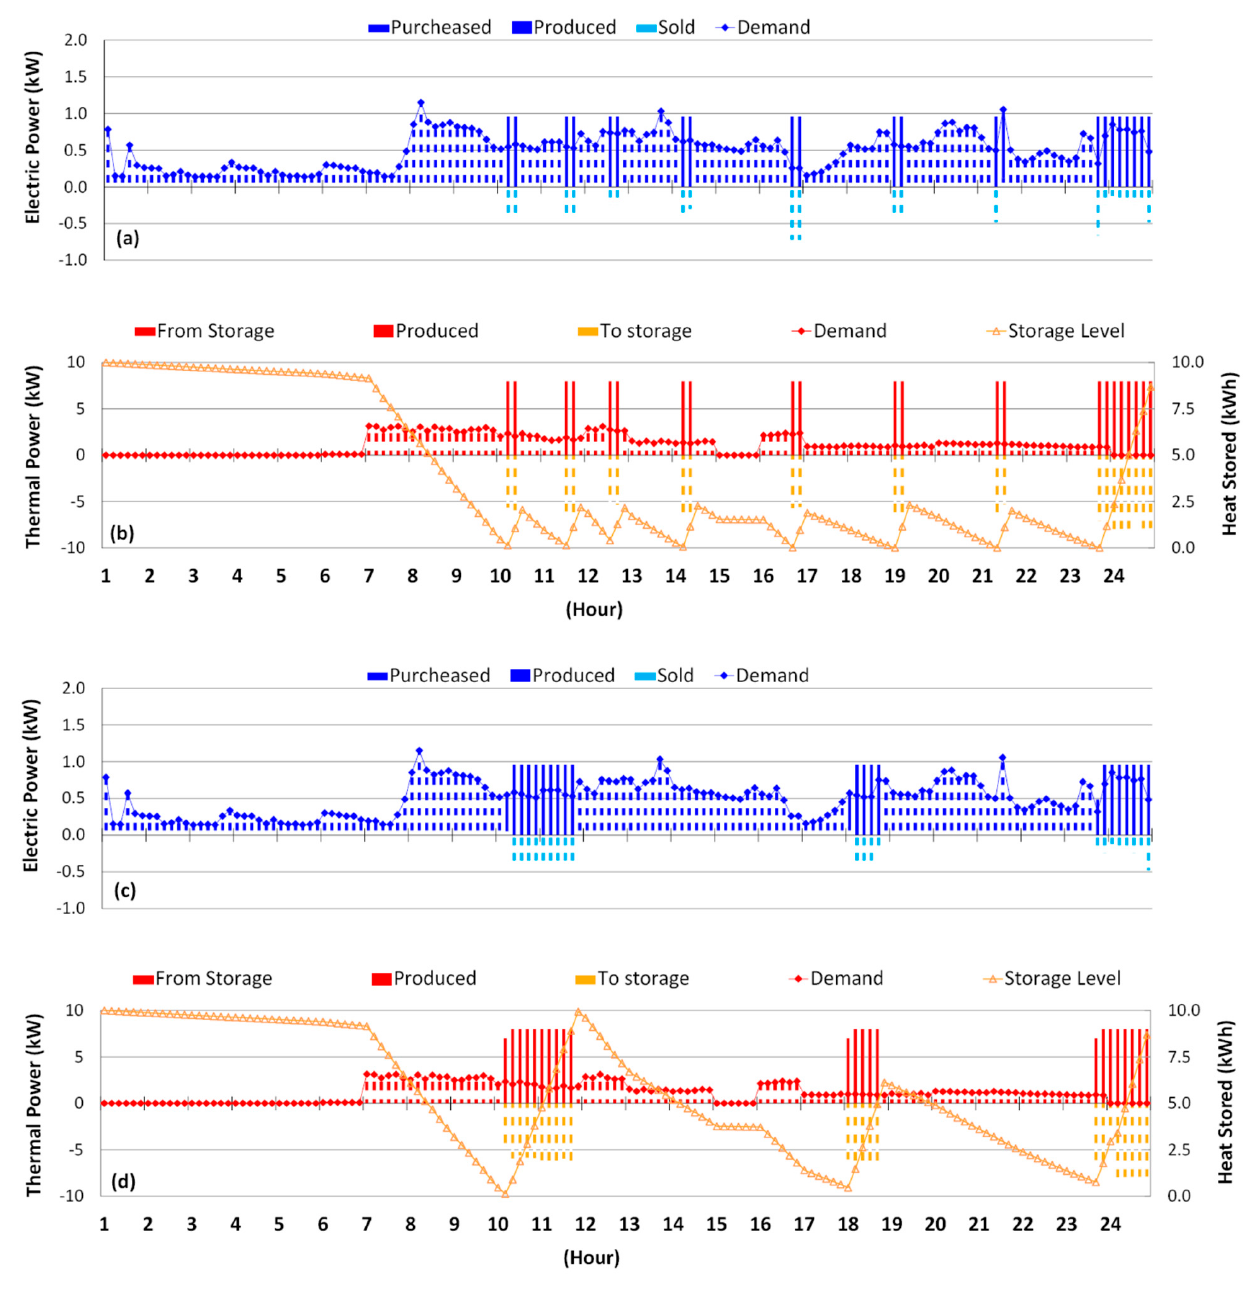
Figure 7. Computational results for a 10 kWh thermal storage (out of which 1 kWh was due to the heating system and 9 kWh to the thermal storage tank): ( a ) Electric and ( b ) thermal scheduling without startup and shutdown penalization; ( c ) electric and ( d ) thermal scheduling with startup and shutdown penalization.